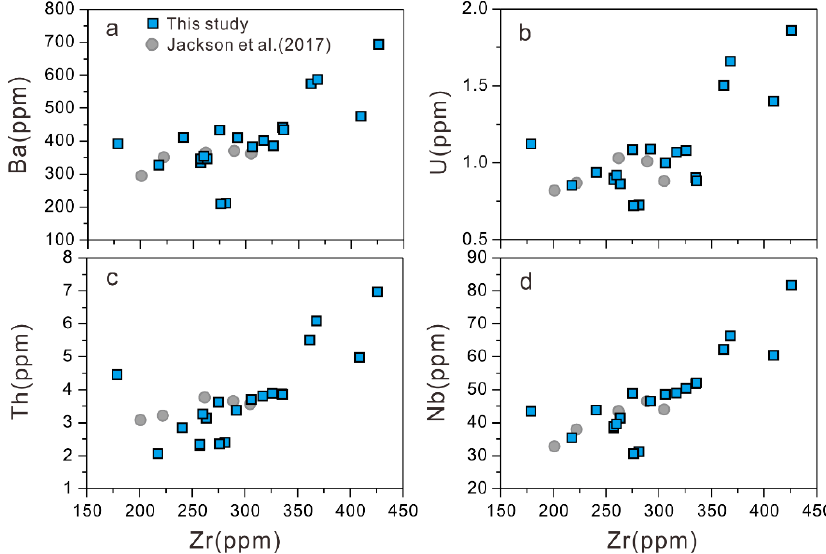
Figure 7. Variations of ( a ) Ba, ( b ) U, ( c ) Th, and ( d ) Nb contents with Zr contents of Pohnpei lavas. Previously reported data (light-gray circles) [10] are also plotted.